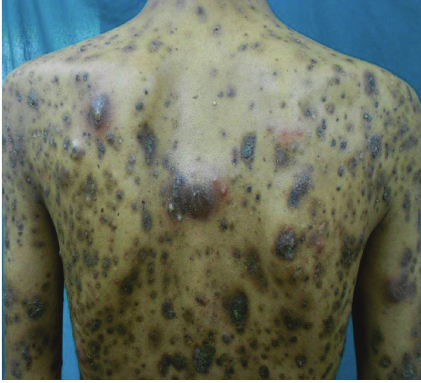
Figure 4: Perivascular and periappendageal infiltration of neu- trophils, lymphocytes, and macrophages. (H&E: ×